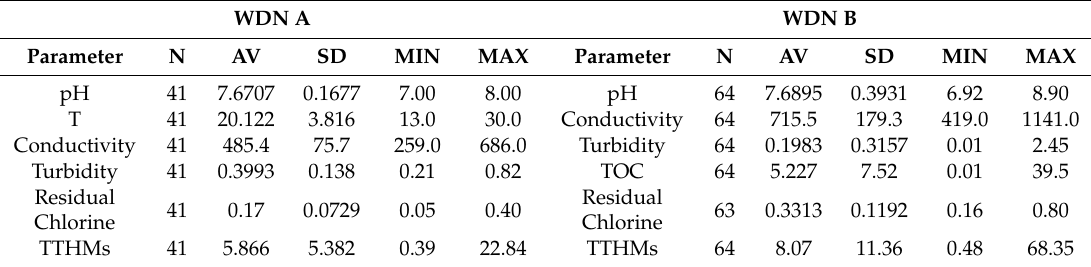
Table 2. Total number, average, standard deviation (SD), minimum and maximum values of the parameters in both water distribution networks (WDNs).